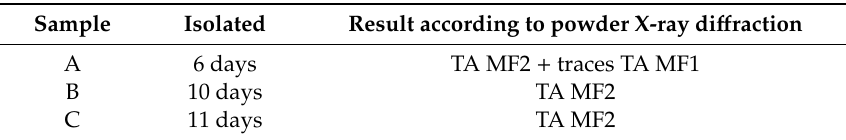
Table 2. Monitoring of the conversion of TA MF1 to TAM